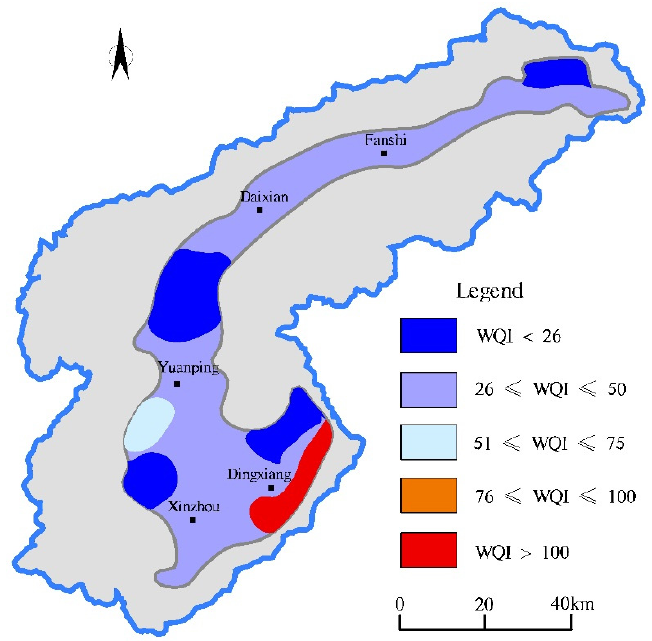
Figure 8. Spatial distribution of water quality index.